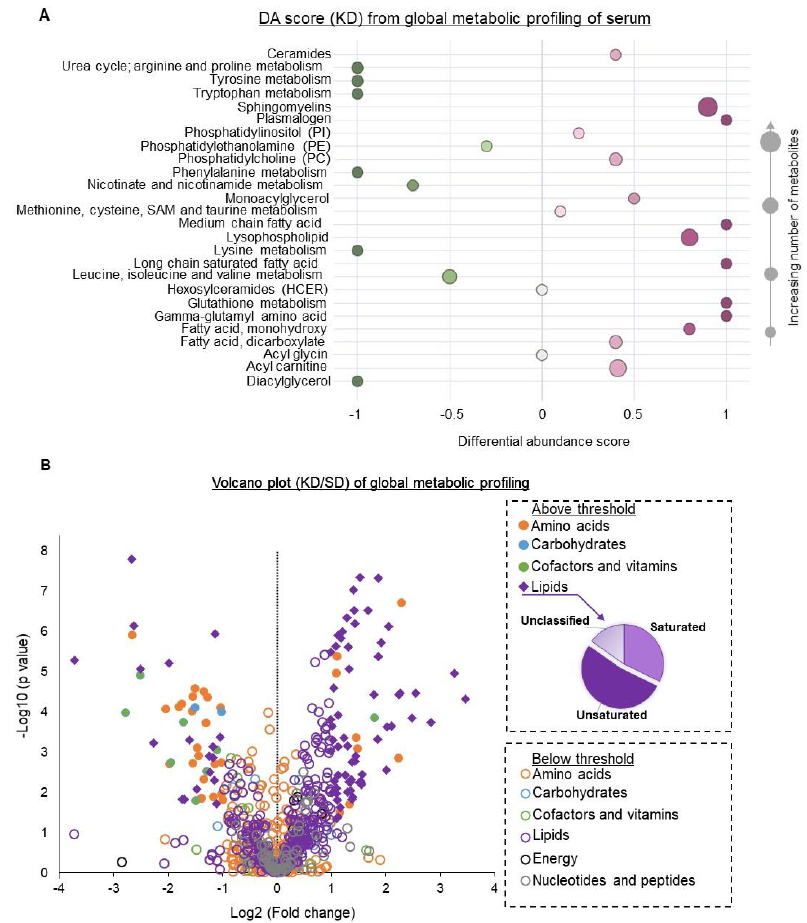
Figure 2. Systemic metabolic changes associated with a ketogenic diet. Global metabolic profiling was performed on serum from mice fed a KD or SD (n = 6/group). ( A ) Significantly altered metabolites were classified into major metabolic pathways, and the differential abundance (DA) scores of each pathway were plotted. ( B ) Metabolic profiles of KD and SD were classified into lipid, nucleotides and peptides, amino acids, carbohydrates, and cofactor and vitamin metabolism. Values from each metabolite were used to calculate log2 (fold change KD/SD) and plotted against — Log10 ( p - value) to generate a volcano plot. Metabolites with >2-fold change and with a p value < 0.05 were considered to be above the threshold (solid circles or diamonds). Metabolites with <2-fold change or with a p value > 0.05 were below the threshold (empty circles). Lipids with significant p values were characterized into 3 groups (saturated, unsaturated, and unclassified) based on saturation levels and their abundance and depicted as a pie chart .